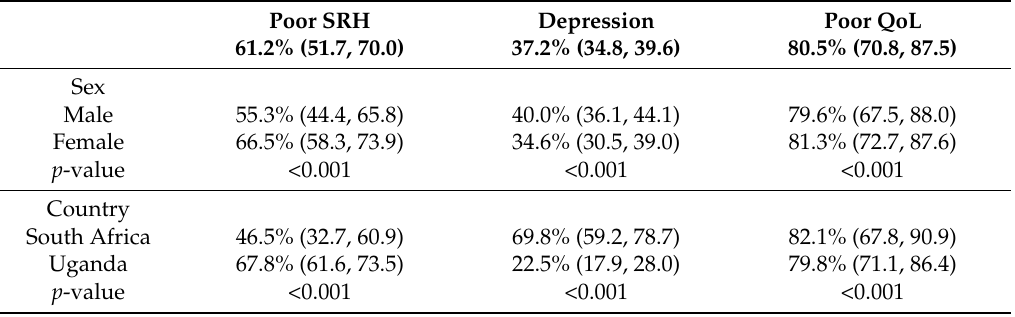
Table 4. Differential prevalence in physical and cognitive ADL difficulties by sex and